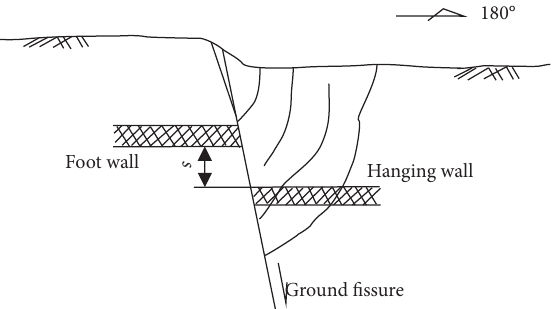
Figure 2: Movement section of ground fissure [25].